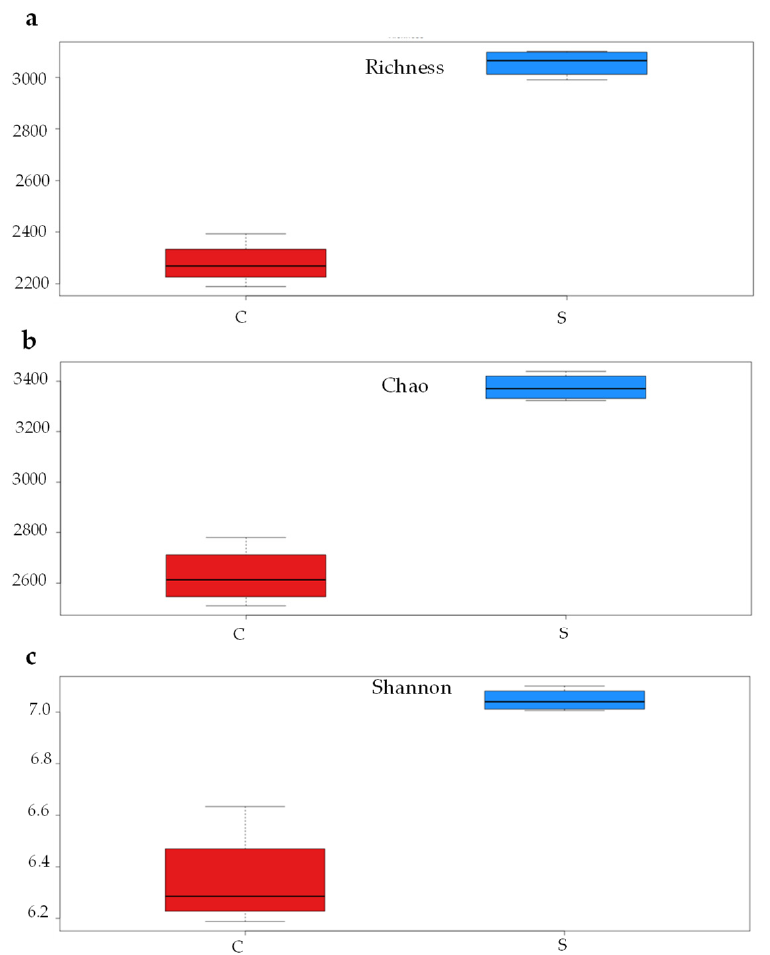
Figure 2. Boxplot analysis of the alpha-diversity estimates of different bacterial communities. ( a ). Richness of OTUs; ( b ). Chao - the Chao1 estimator; ( c ). Shannon - the Shannon index.